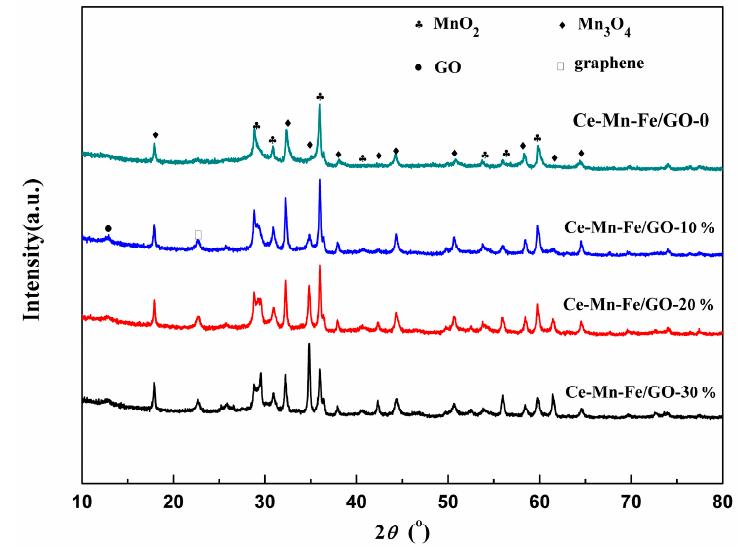
Figure 1. The XRD patterns of Ce-Mn-Fe/GO-x (x = 0, 10%, 20%, 30%).